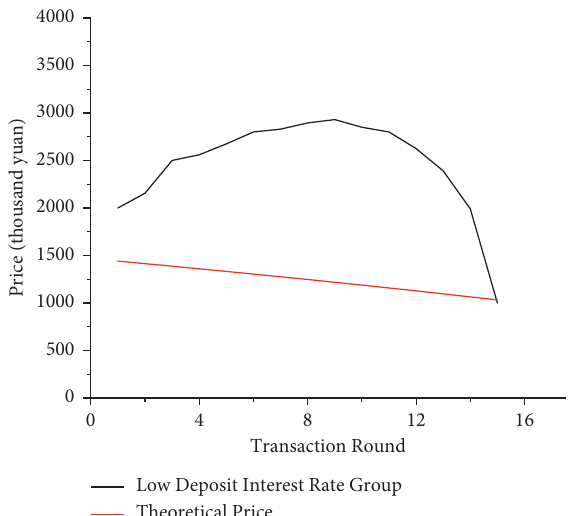
Figure 1: The average trading price and theoretical price of the low deposit interest rate group of each transaction round.